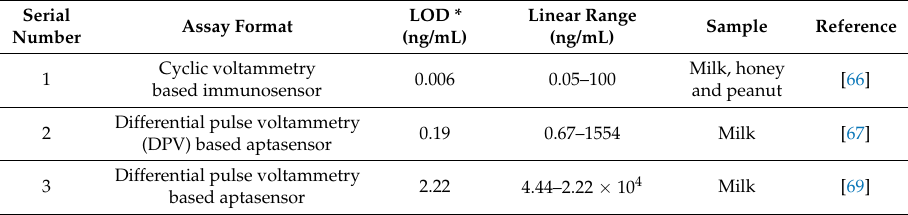
Table 3. Summary of reviewed studies on electrochemical biosensors for the detection of